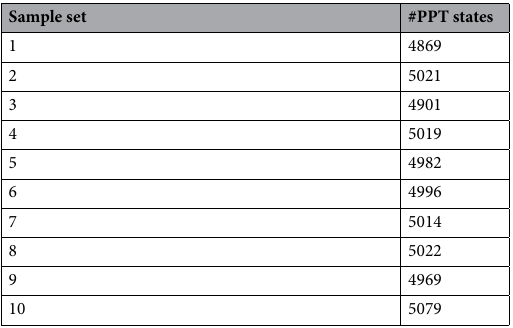
Table 1. Number of PPT states in sample sets of size 10,000. Table shows ten sample sets containing 10,000 states each and the number of PPT states within. The empirical mean is 4987.2 with empirical standard deviation of 61.7. These results are in agreement with the expected mean of 5000 and standard deviation of 50 according to the binomial distribution. For the exemplary analysis below we use a sample size of 10,000 states. The determined empirical values imply that the obtained numbers for the size of relative volumes have an 3 0.1% . statistical error in the magnitude of 10 − =